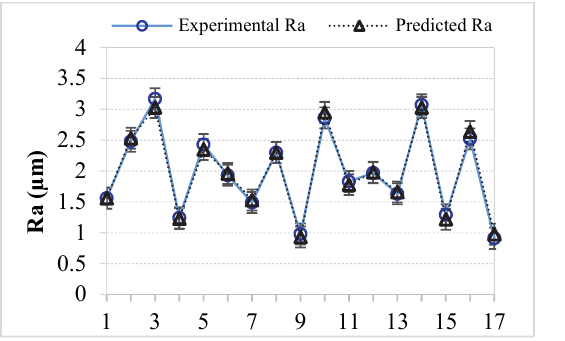
Fig. 8. Comparison between measured and predicted values for surface Fig. 9. Comparison between measured and predicted values for cutting